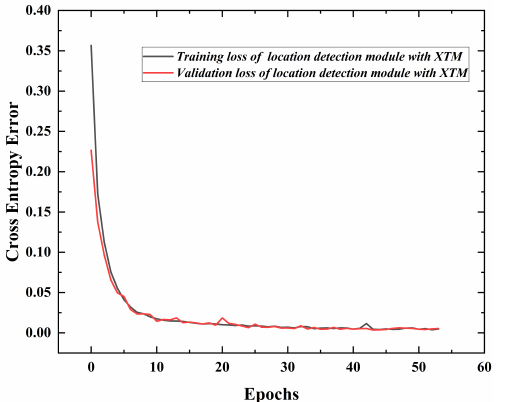
Figure 7. Loss Vs epoch curve during the training of LDM using estimates from XTM